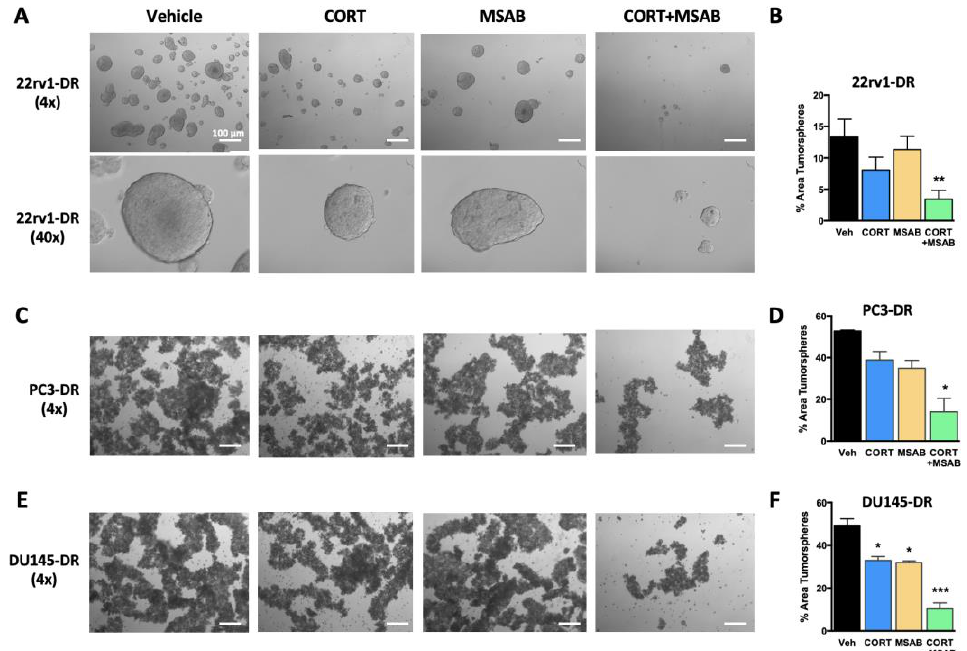
Figure 9. Co-inhibition of GR and β -catenin impairs docetaxel-resistant prostate tumorsphere for- mation. DTX-resistant 22rv1-DR ( A ), PC3-DR ( C ), and DU145-DR ( E ) cells were cultured as tu- morspheres in ultra-low adherence dishes in Tumorsphere XF medium containing 10 nM DTX and vehicle (DMSO), CORT-108297 (CORT, 1 µ M), MSAB (1 µ M), or CORT-108297 plus MSAB (CORT + MSAB, 1 µ M each) for 6 days and imaged using an Olympus IX70 microscope equipped with Hoffman modulation. Images were acquired at 4 × or 40 × magnification. The scale bar for all images (4 × magnification) is set at 100 µ m. Tumorsphere area was quantified from quadruplicate images for each cell line ( B , D , F ). Data are representative from 3 independent experiments and are represented as mean ± SEM. * p < 0.05, ** p < 0.01, *** p < 0.001.